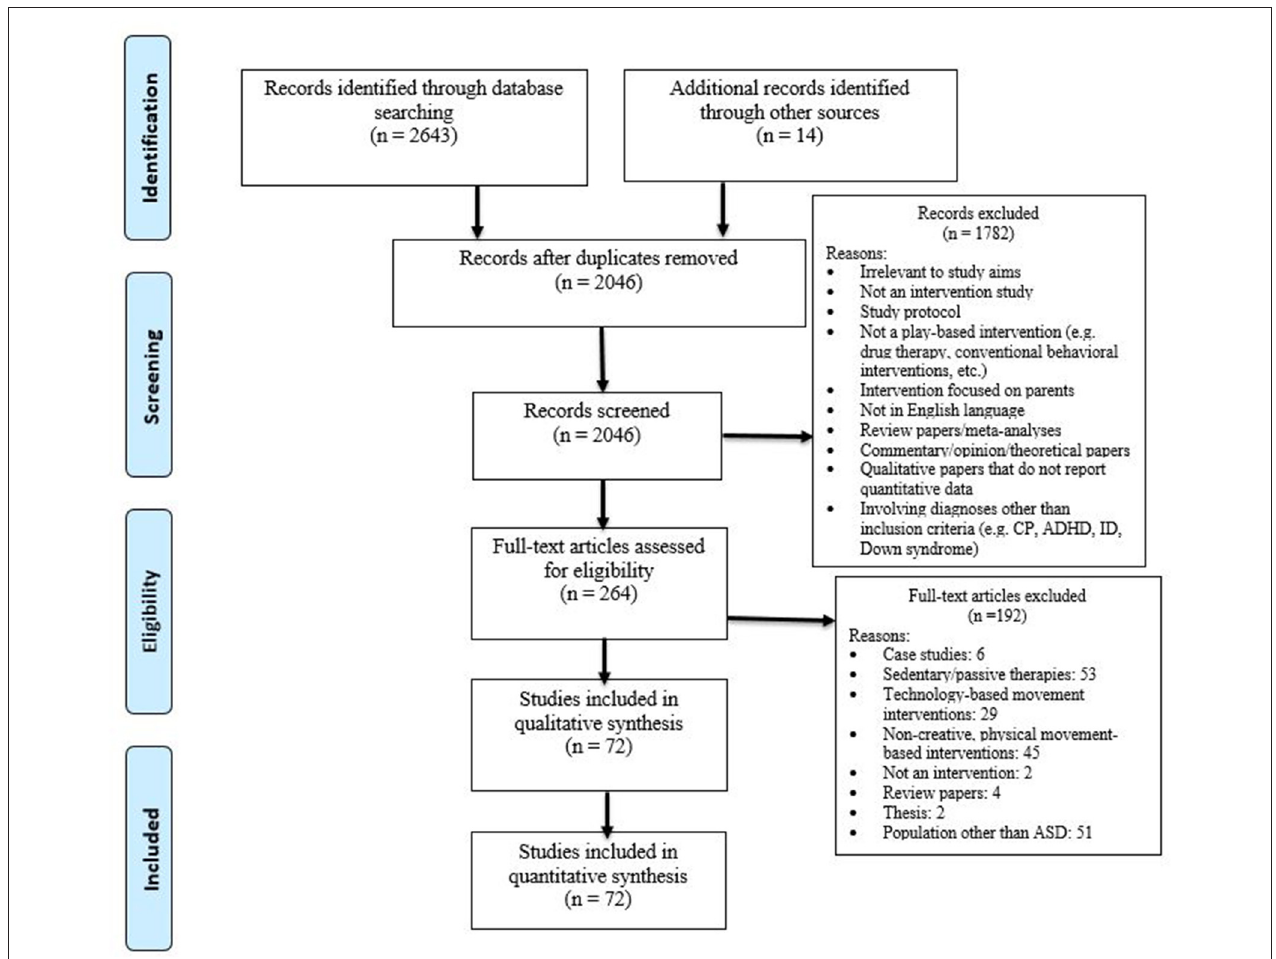
FIGURE 1 | PRISMA flow diagram of search strategy and study selection